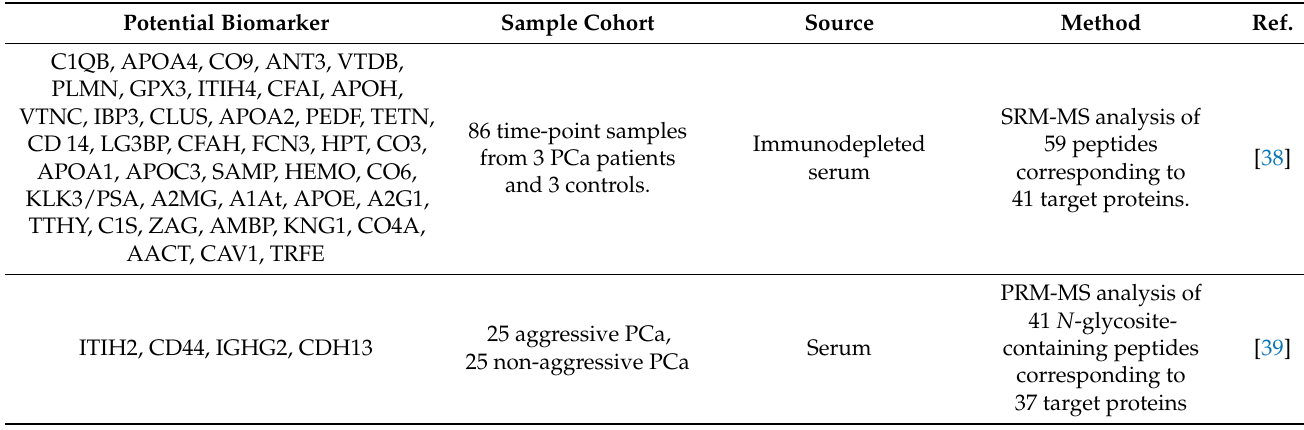
Table 2. List of MS-based targeted proteomics studies of PCa protein markers from serum. Potential Biomarker Sample Cohort Source Method